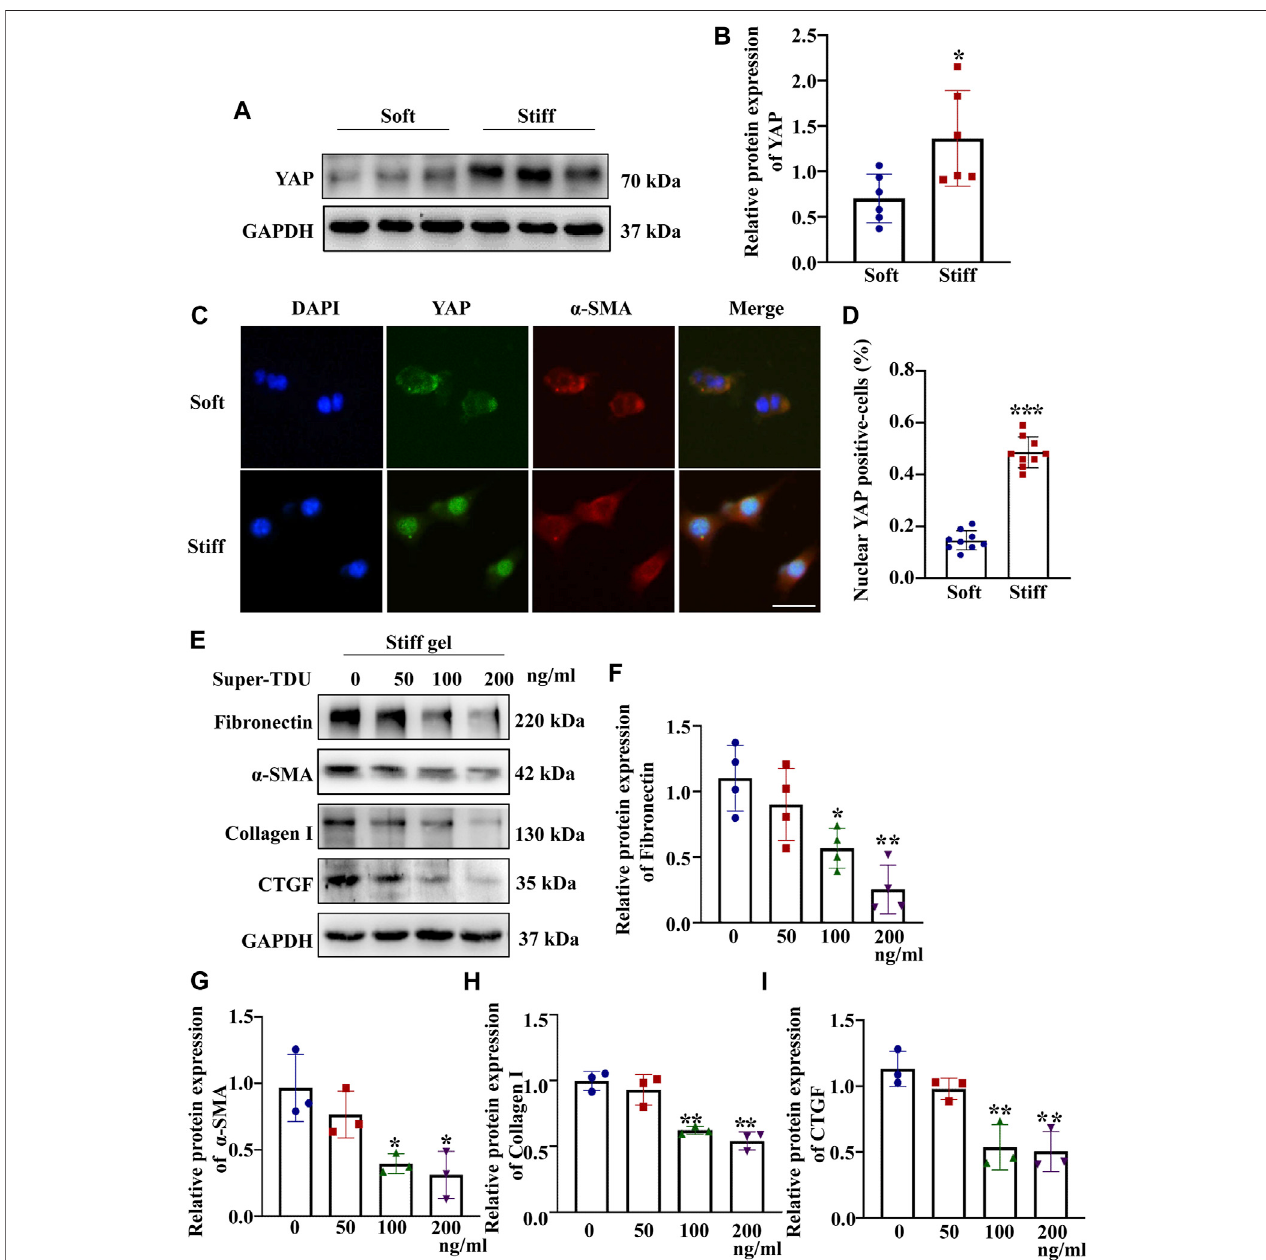
FIGURE 2 | ECM stiffness activates MCs through YAP. MCs were cultured on hydrogels of different stiffness (2 and 50 kPa) for 48 h. (A) Representative Western blot bands show the protein expression level of YAP. (B) The bar graph shows the result of semi-quantitative measurement of YAP ( n (cid:1) 6; * p < 0.05, ** p < 0.01, *** p < 0.001). (C) Representative photomicrographs show fl uorescence staining with anti- α -SMA (red) and anti-YAP (green) antibodies in cells cultured on the soft and stiff hydrogels. Scale bar (cid:1) 25 µm. (D) The percentage of cells with predominantly nuclear YAP staining. ( p < 0.001). (E) Western blot bands show expression levels of Fibronectin, Collagen 1, α -SMA and CTGF after which MCs were incubated with Super-TDU at various concentrations on the stiff gel (50 kPa) for 24 h. The bar graph shows the results of semi-quantitative of Fibronectin (F) , α -SMA (G) Collagen 1 (H) and CTGF (I) measurements ( n (cid:1) 3; * p < 0.05, ** p < 0.01, *** p < 0.001).